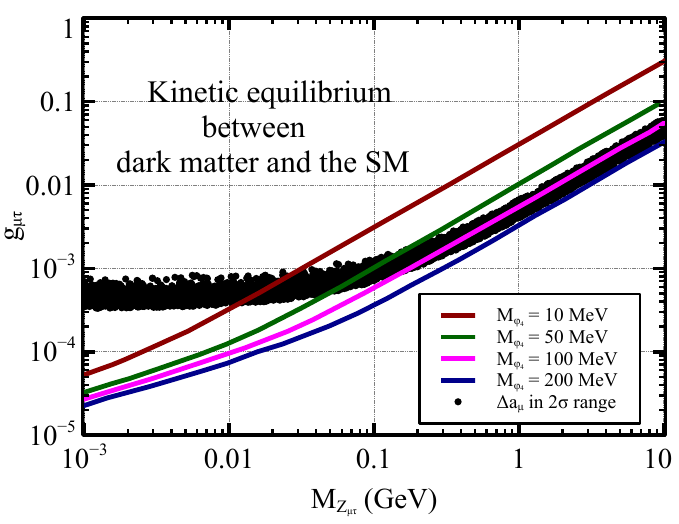
for which dark matter maintains kinetic equilibrium with µτ and ν µ τ